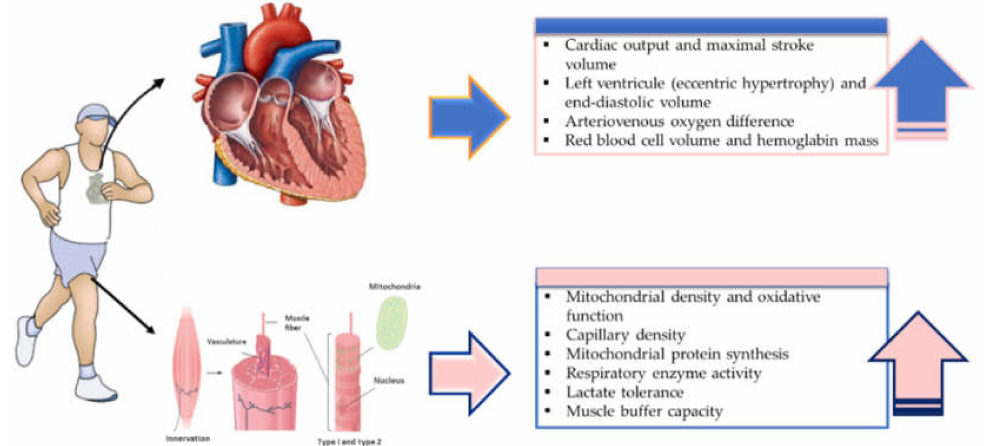
Figure 3. Central and peripheral adaptations to exercise